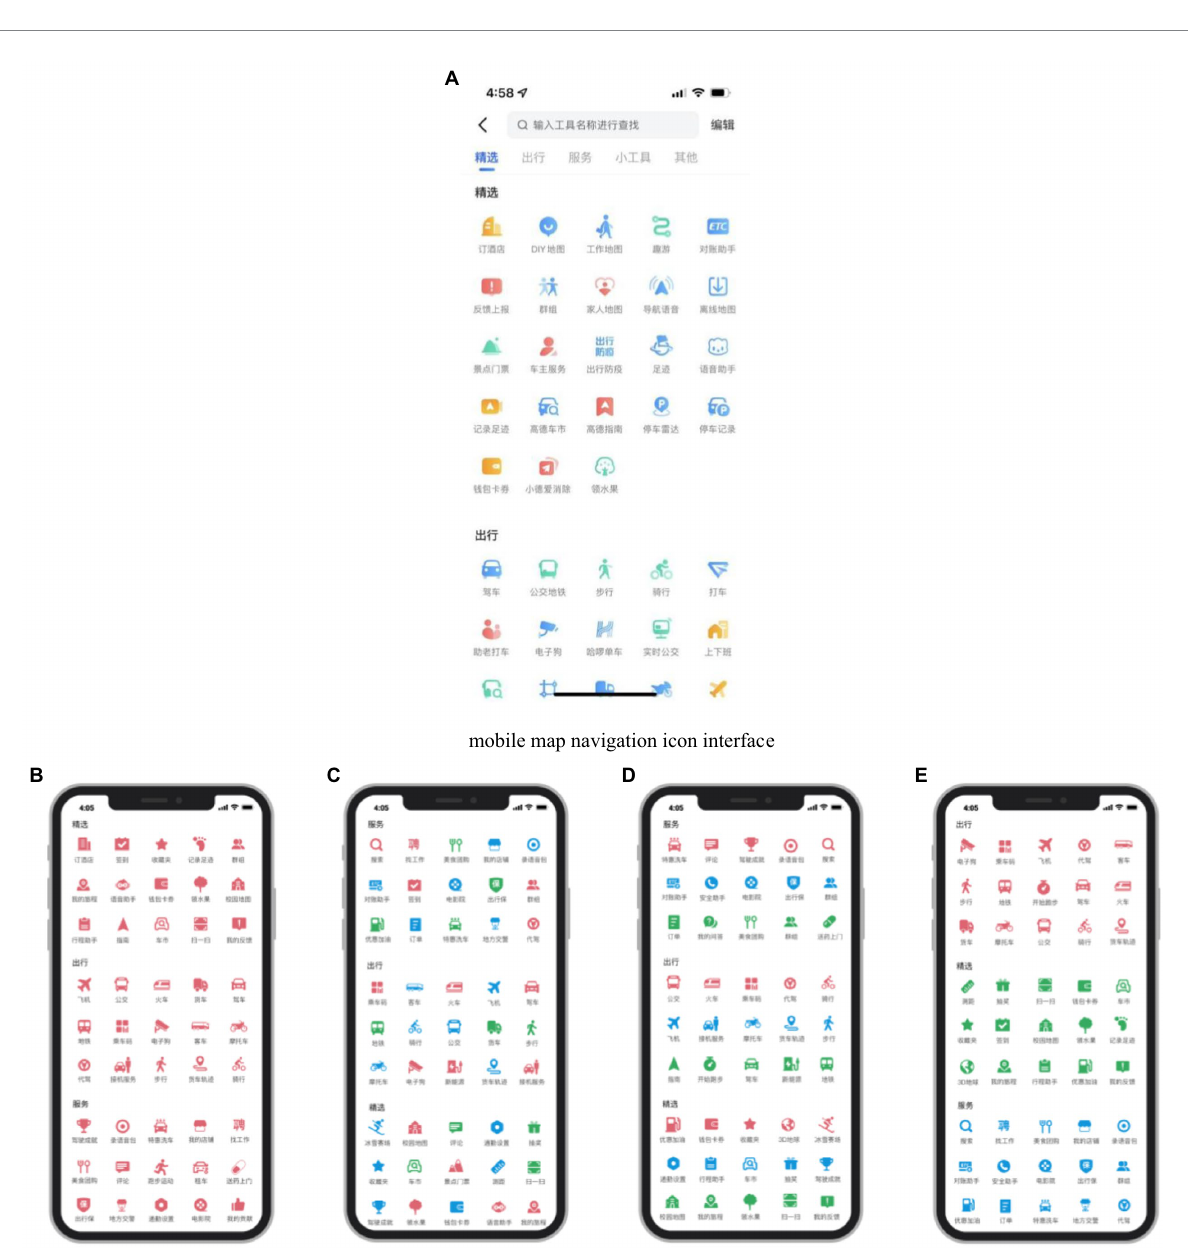
FIGURE 1 The icon interface used in the experiment. (A) mobile map navigation icon interface. (B) Single red icon interface (C) Color random distribution icon interface (D) 1 × 5 grouping interface (E) 3 × 5 grouping